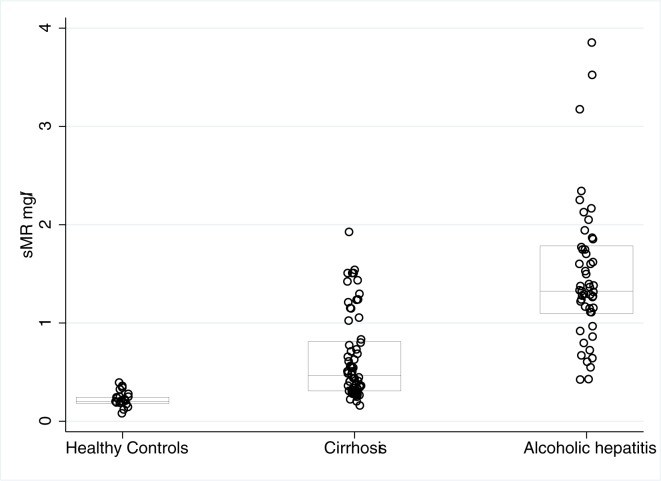
sMR levels in Alcoholic hepatitis, Cirrhosis & healthy control subjects.